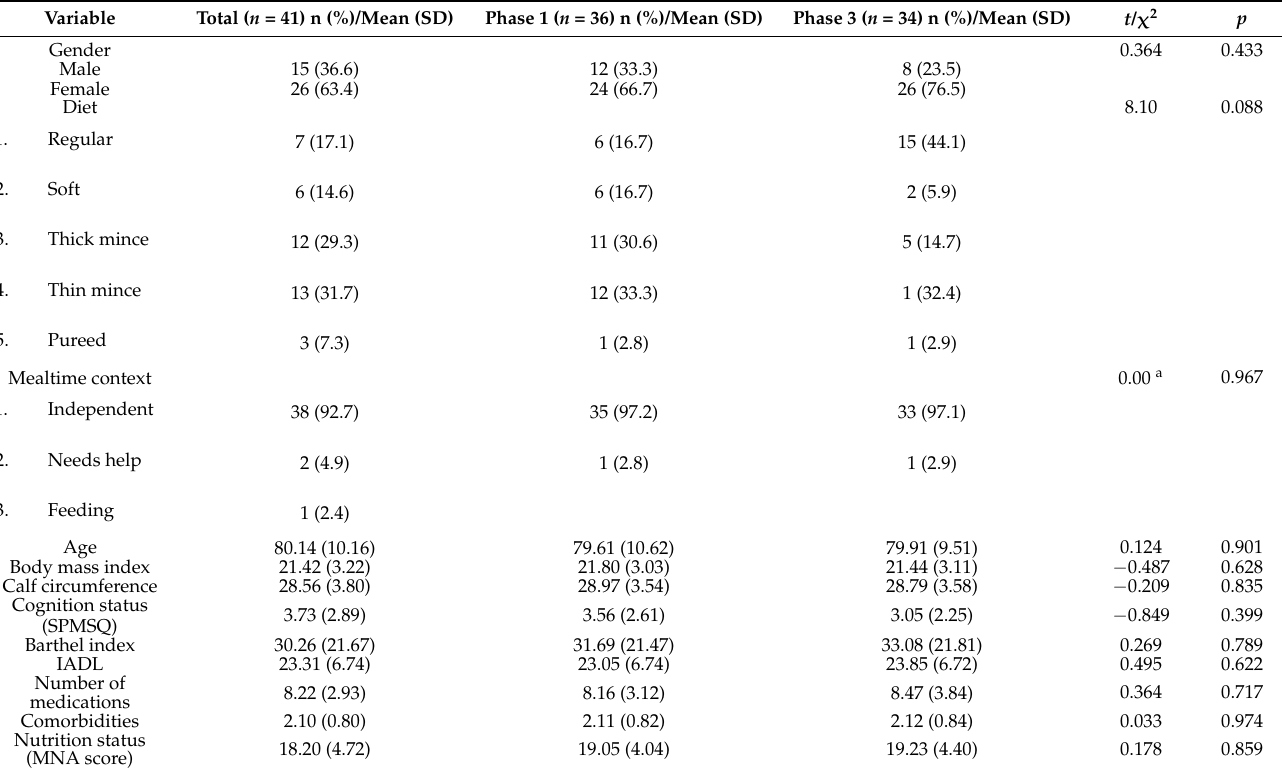
Table 2. Participant characteristics.